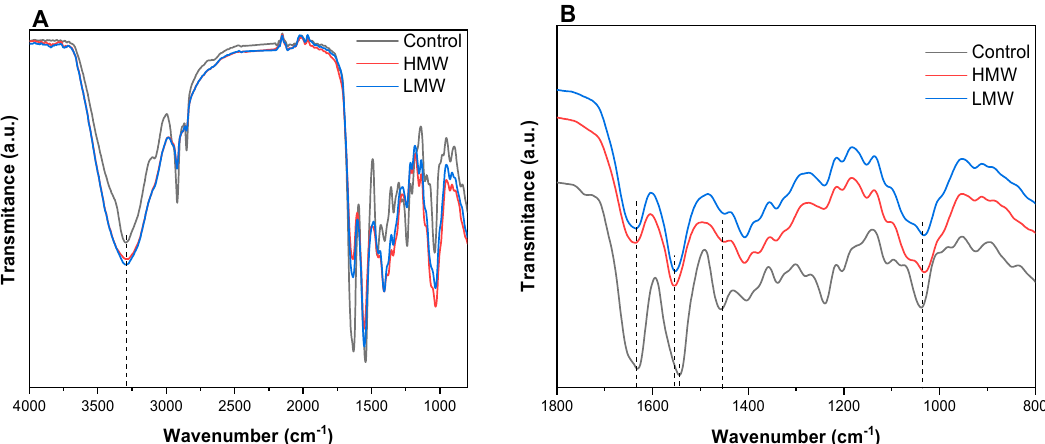
Figure 2. FTIR spectra of control scaffolds and collagen scaffolds with high molecular weight (HMW) and low molecular weight (LMW) chitosan ( A ) from 4000 to 800 cm − 1 and ( B ) from 1800 to 800 cm − 1 . Table 2. Wavenumber of amide I (V I ) and amide II (V II ) bands, as well as the wavenumber di ff erence between them (V I –V II ), for control sca ff olds and collagen sca ff olds with HMW and LMW